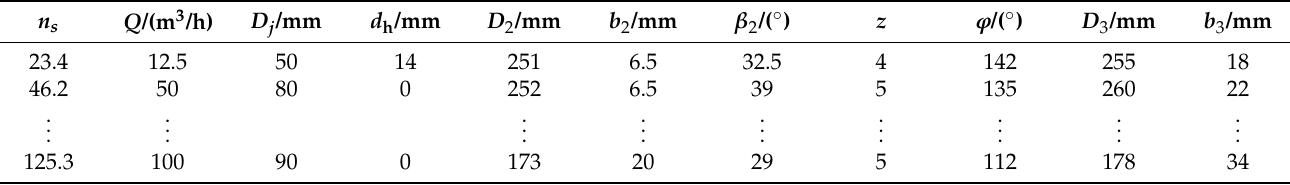
Table 3. Geometric parameters of centrifugal